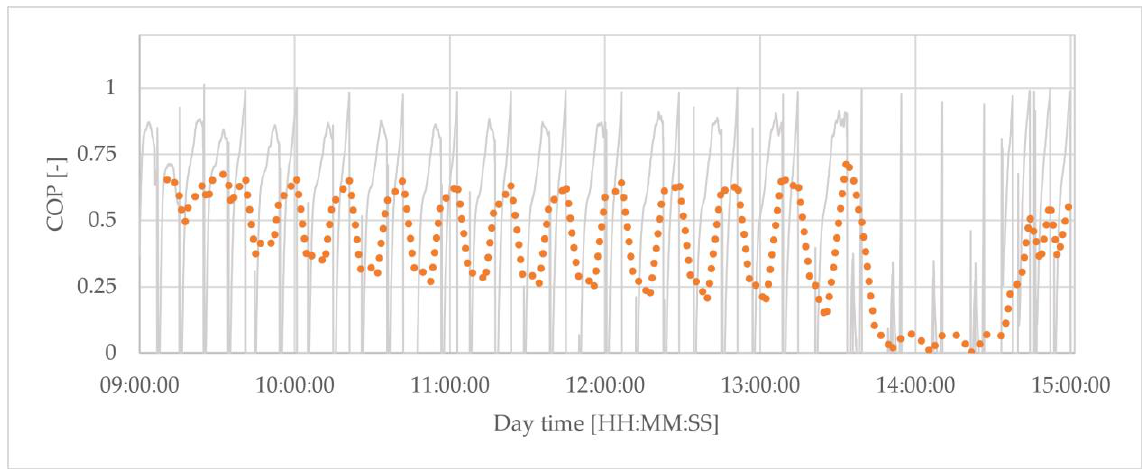
Figure 23. COP values over time for 21st August.